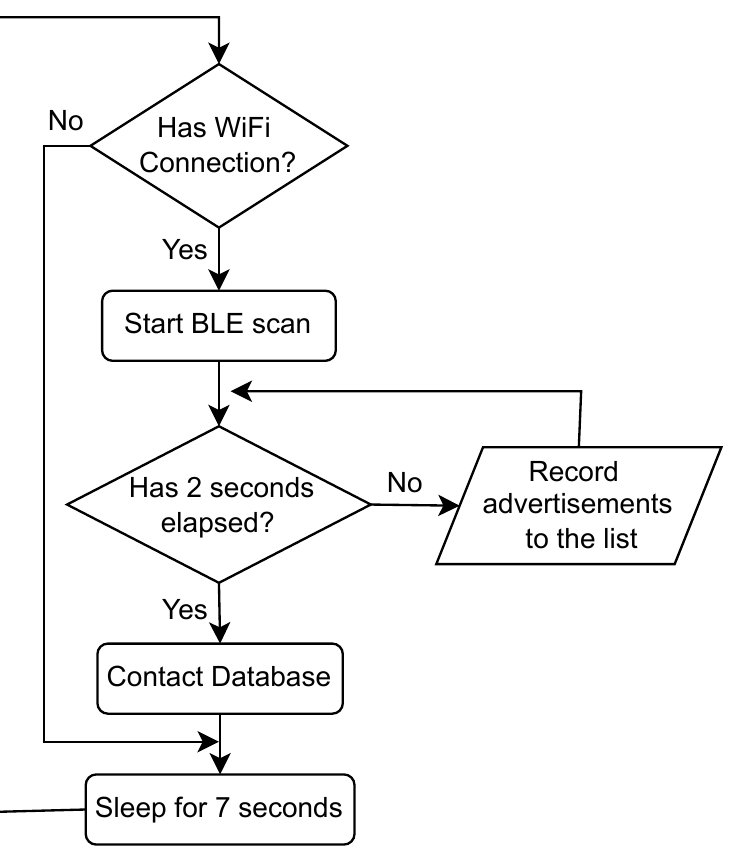
Figure 5. Operation flowcharts for BLE wearable